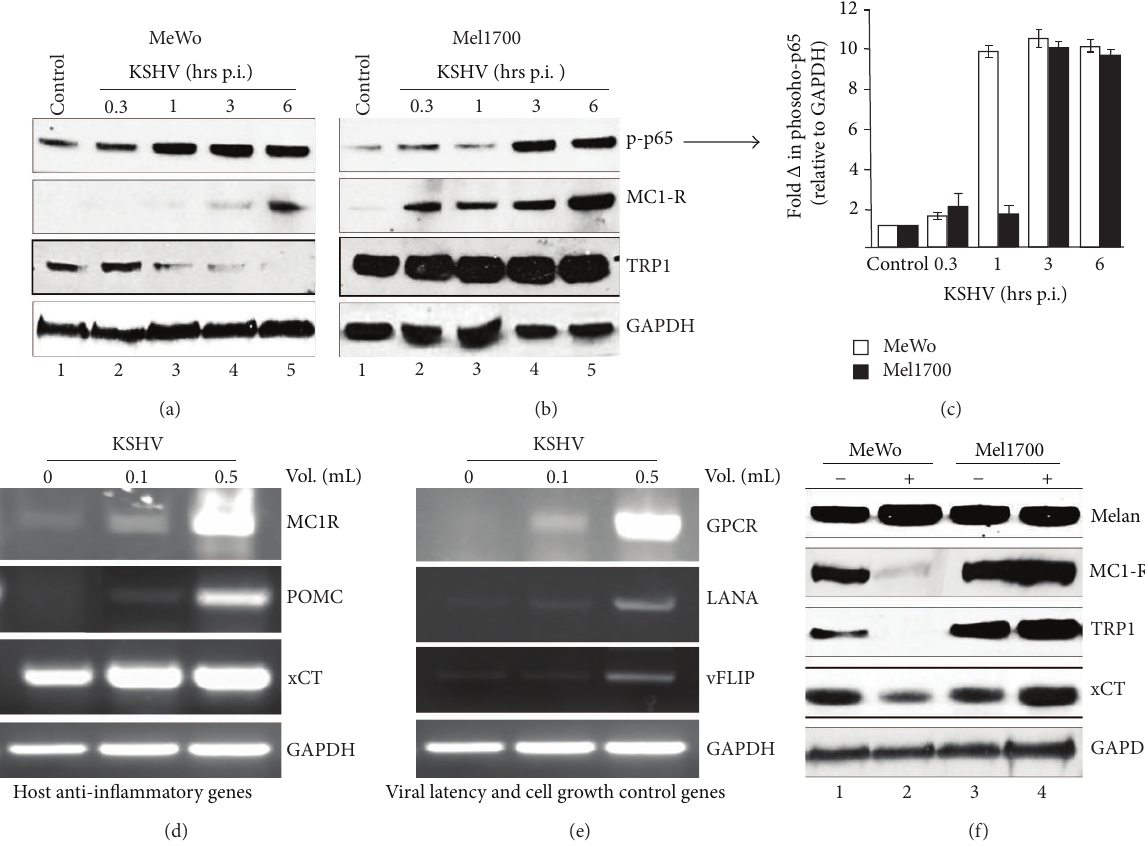
Figure 7: A link between KSHV latency and the MC1-R signaling axis in skin-derived cell lines. (a) Western blot analysis of phosphorylated NF- 𝜅 B p65, MC1-R, and TRP-1 in total cell lysates extracted from MeWo (a) or Mel1700 (b) cells either uninfected (control) or acutely infected with KSHV for 0.3 h, 1h, 3 h, or 6h. GAPDH was used as loading control. (c) ImageJ quantitation of the p65 band intensities in (a) and (b) relative to GAPDH controls. (d) Mel1700 cells were infected in 6-well plates with increasing volumes (mL/well) of concentrated supernatant containing infectious KSHV, and total RNA from infected cells was subjected to RT-PCR using primer sets for host anti-inflammatory MC1R, POMC, and SLC7A11. (e) Equal aliquots from the same RNA used in (d) were subjected to RT-PCR analysis for select viral latency and cell growthcontrolgenes(i.e.,GPCR,LANA,andv-FLIP).(f)Westernblotanalysisofthemelanomacellmarker,MelanA,andanti-inflammatory genes MC1-R, TRP1, and SLC7A11 in total cell lysates of uninfected ( − ) or chronically infected (+) long-term cultures of MeWo-KSHV and Mel1700-KSHV cells. GAPDH was used as an internal control for both the RT-PCR (e) and western blot